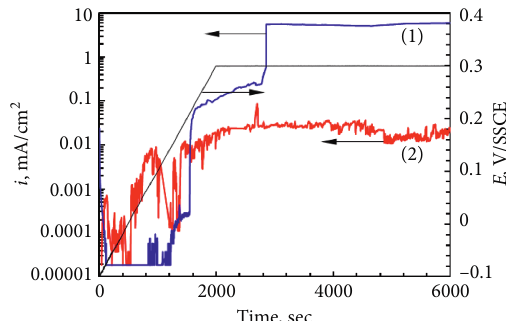
Figure 3: Potentiostatic polarization of AISI 316 stainless steel in 3.5% NaCl solution. 1: nonvibrated; 2: vibrated. Applied potential 0.3V/SSCE. Ultrasound parameters: frequency 27kHz; power